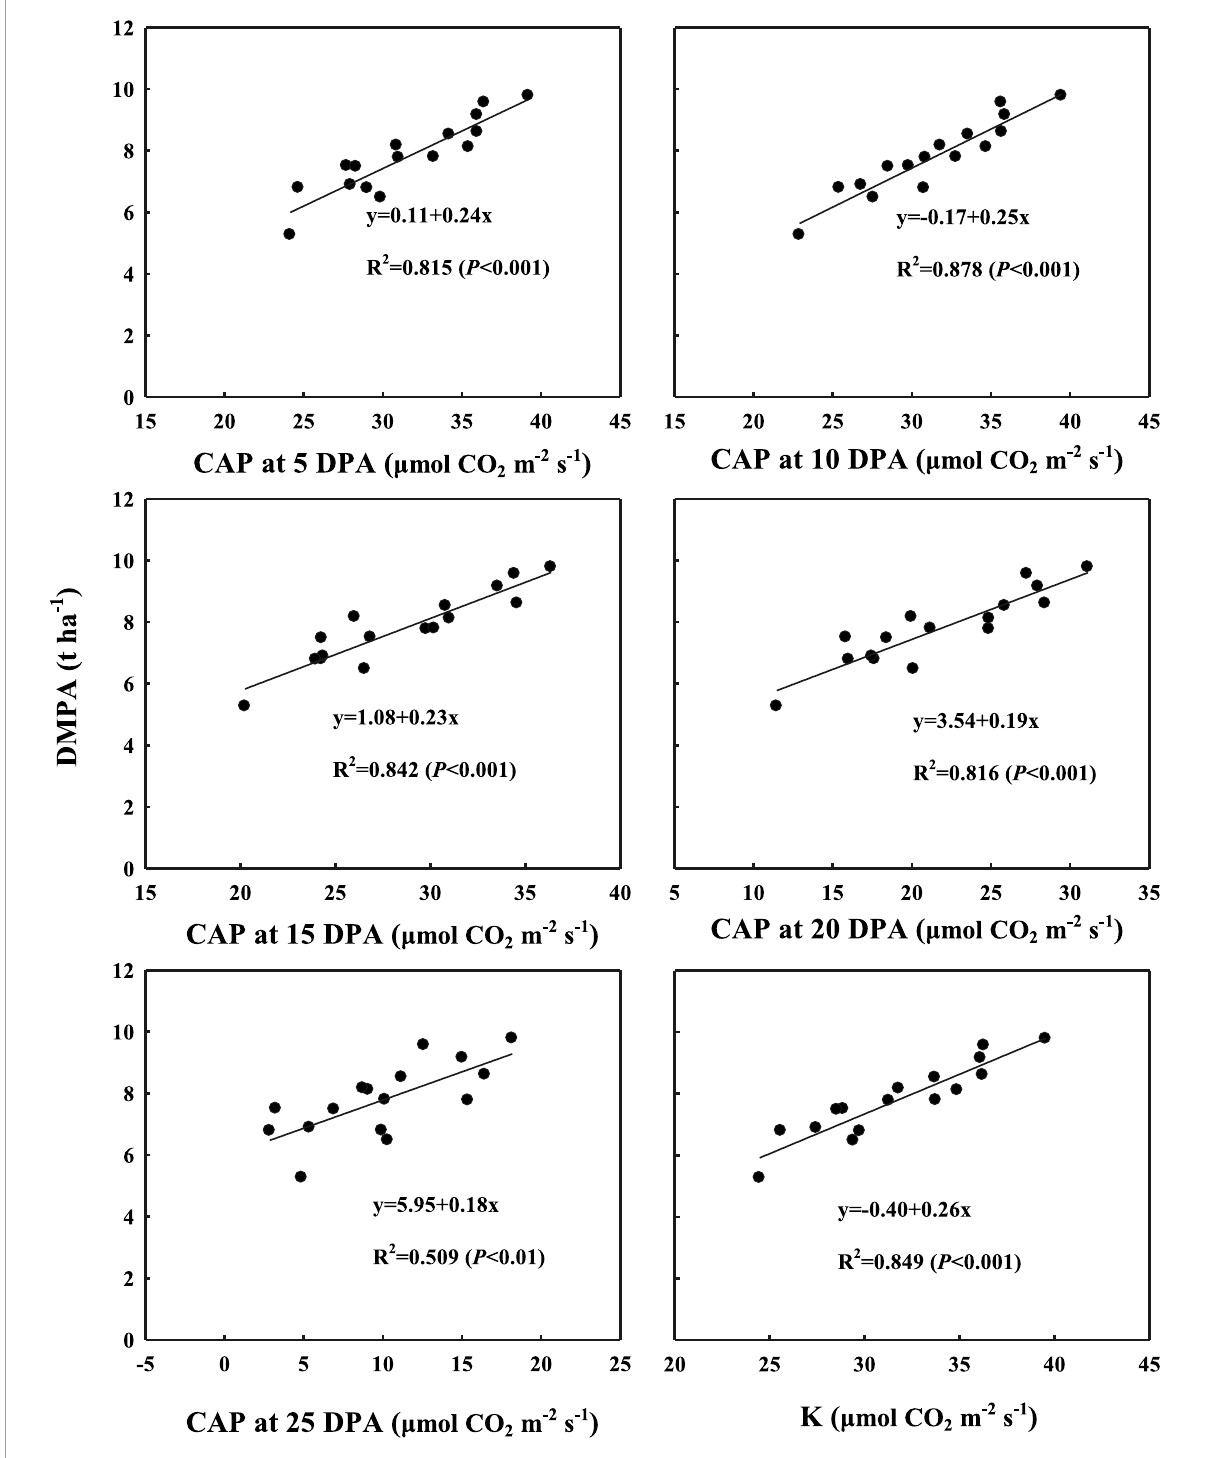
FIGURE5 Correlation analyses between dynamic changes in canopy apparent photosynthesis (CAP) from 5 days post-anthesis (DPA) to 25 DPA and the highest theoretical CAP value (K) with dry matter amount post-anthesis (DMPA). Values are means of three replicates per treatment.